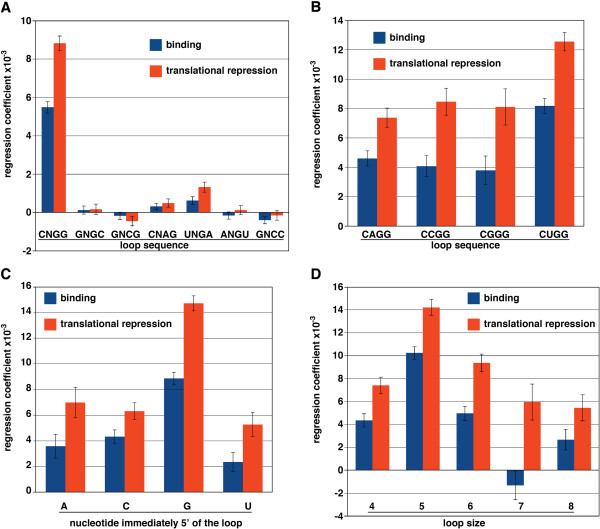
SREs are enriched in Smaug-bound mRNAs and those that are translationally repressed by Smaug. Multiple linear regression was used to simultaneously assess the contribution of various stem-loop structures to Smaug binding and Smaug-mediated translational repression. Smaug binding was quantified using the fold enrichment in Smaug RIPs compared to control RIPs and Smaug-mediated translational repression was quantified by comparing the TI in smaug-mutant versus wild-type embryos. The structures tested in (A) included a consensus SRE with the loop sequence CNGGN0-4 while the other sequences tested carried the indicated changes in invariant positions of the loop that are predicted to reduce or block Smaug binding. The structures tested in (B) included all possible nucleotides in the second position of the loop. The structures tested in (C) included all possible nucleotides in the position that immediately precedes the loop. The structures tested in (D) included loops matching the CNGGN0-4 consensus where the loop size varied from four to eight nucleotides. Error bars indicate standard error of the mean.